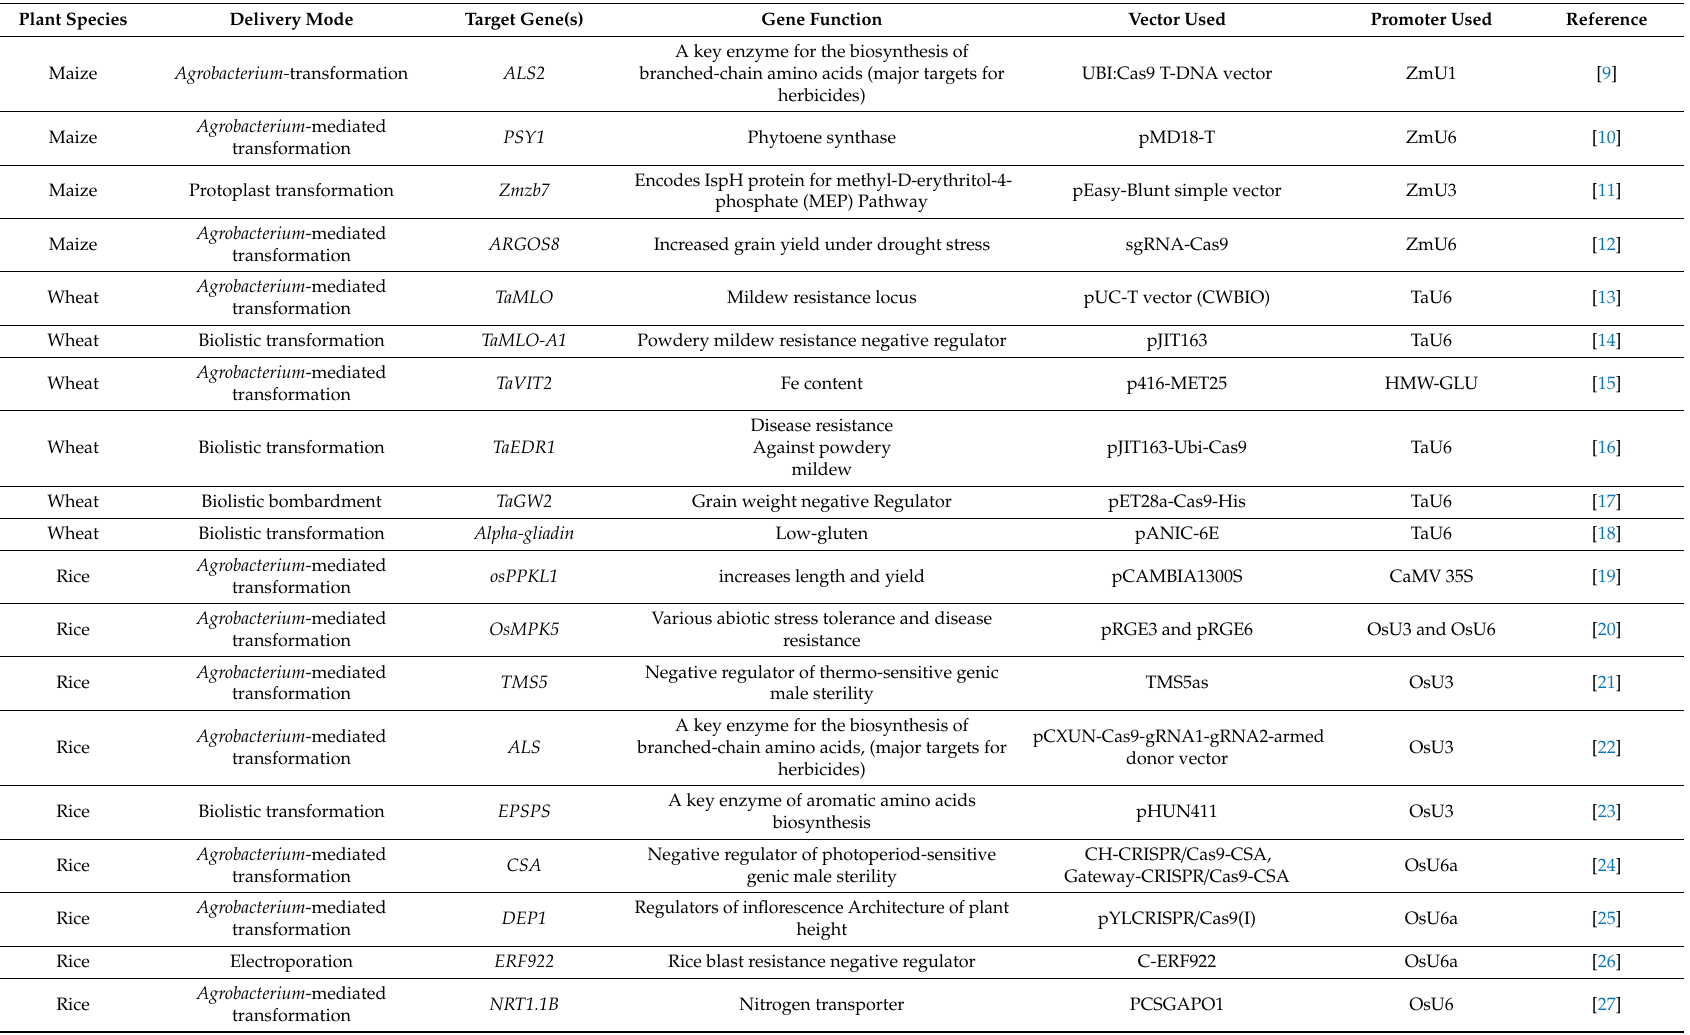
Table 1. List of significant gene editing studies in cereal